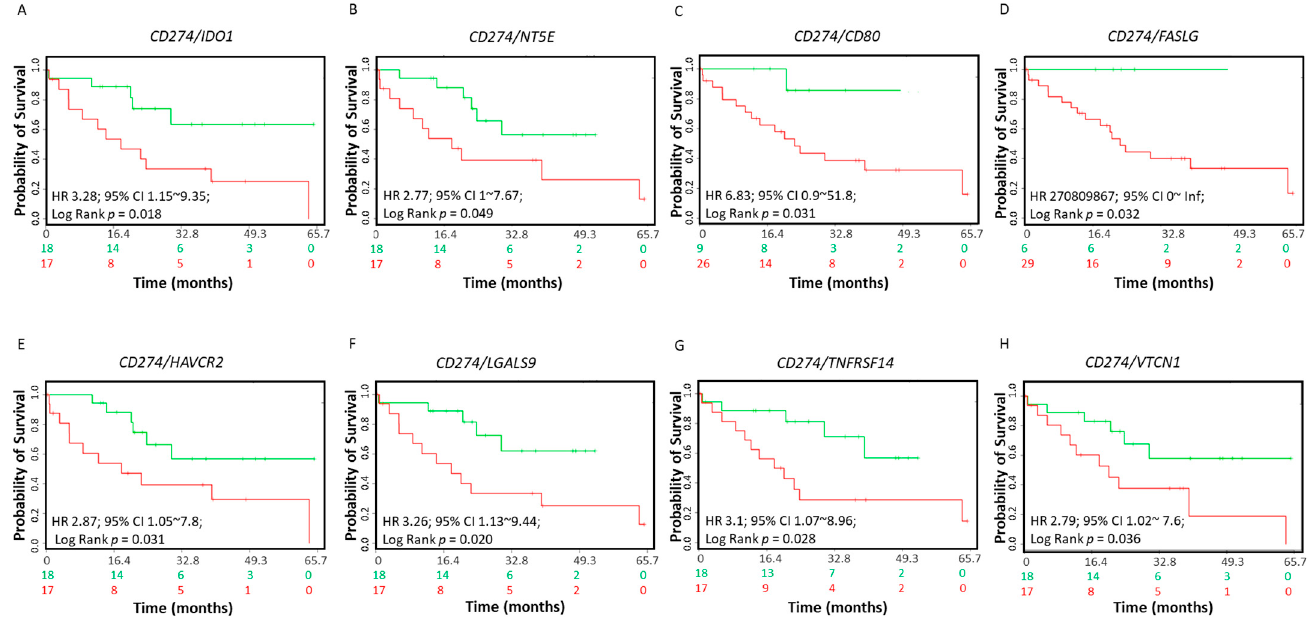
Figure 3. Relationship of immune modulators in combination with CD274 ( PD-L1 ) and survival in CCA patients. The Kaplan–Meier survival curves in SurvExpress CCA patients for the gene expression of ( A ) CD274 / IDO1 , ( B ) CD274 / NT5E , ( C ) CD274 / CD80 , ( D ) CD274 / FASLG , ( E ) CD274 / HAVCR2 , ( F ) CD274 / LGALS9 , ( G ) CD274 / TNFRSF14 and ( H ) CD274 / VTCN1 . Low-risk groups are indicated in green and high-risk groups are indicated in red. The x-axis presents the study time in months. HR, CI and p -values are shown in the insert.